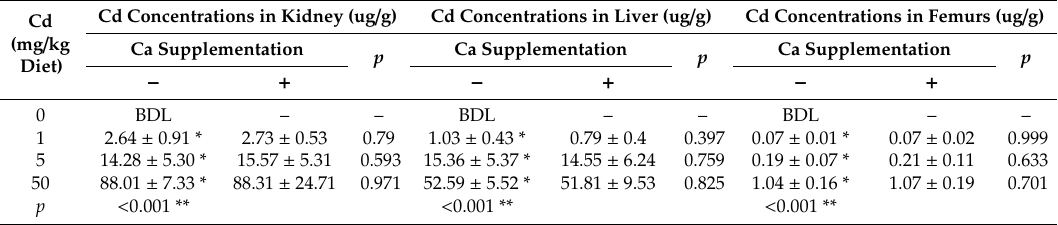
Table 8. Cd concentrations in kidney, liver and femurs in the study of moderate Ca supplementation exposure to di ff erent diet Cd (Exp